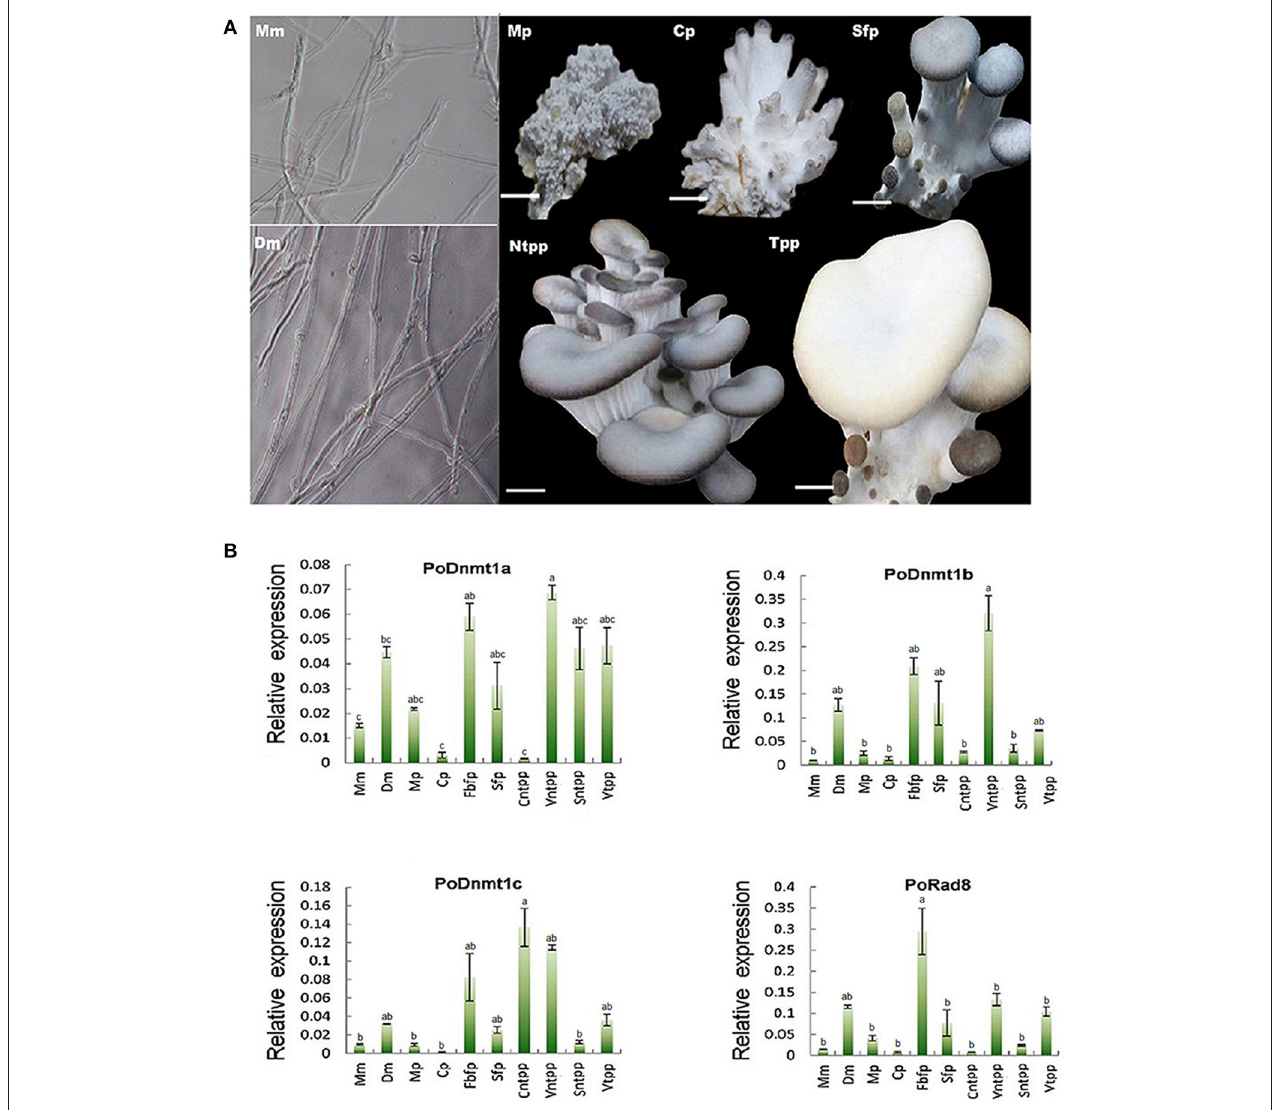
FIGURE 4 | Expression profiles of DNMtase genes in Pleurotus ostreatus. (A) The schematic diagram for different developmental stages of Pleurotus ostreatus. Mm, Dm, Mp, Cp, Sfp, Ntpp, and Tpp represents monokaryotic mycelium, dikaryotic mycelium, mulberries phase, coral-like phase, sporophor formative phase, not turning pale phase, and turning pale phase, respectively. (B) Expression profiles of DNMtase genes during the development of Pleurotus ostreatus . The expression levels relative to ACTIN were measured by quantitative RT-PCR and displayed in log2 scale. The acronyms from left to the right are representative of Monokaryotic mycelium (Mm), Dicaryotic mycelium (Dm), Mulberries phase (Mp), Coral-like phase (Cp), Fruiting body of formative phase (Fbfp), Stip of formative phase (Sfp), Cap of not turning plae phase (Cntpp), Veil of not turning pale phase (Vntpp), Stip of not turning pale phase (Sntpp), Veil of turning pale phase (Vtpp) that were collected for quantitative RT-PCR analysis. Three biological replicates and three technological replicates were done for each data point. Error bars indicate standard deviations (SDs). Letters indicate significant differences at P < 0.05 according to Duncan’s multiple range